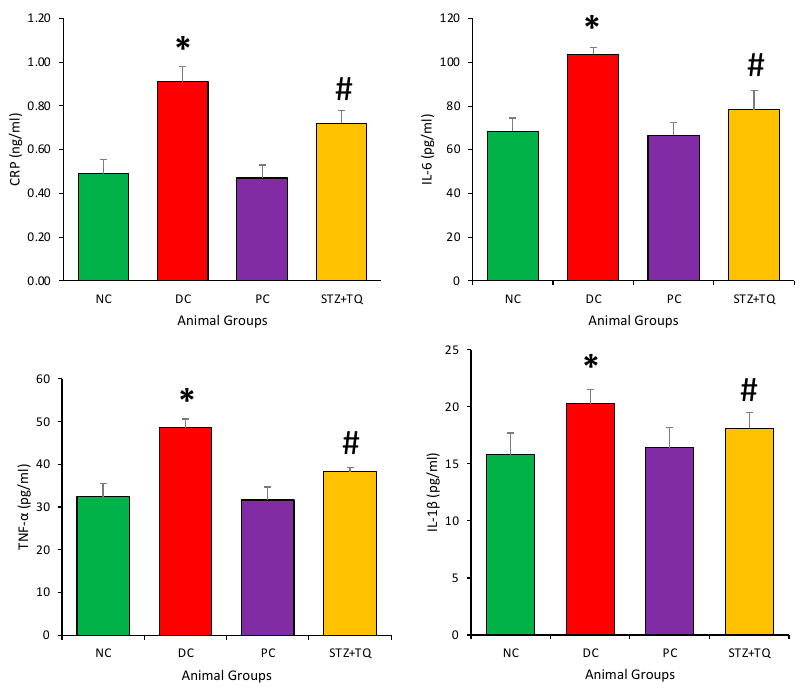
Figure 9. The inflammatory markers level in different groups of rats after 8 weeks of continues treatment. The experimental animals were uniformly divided into each group ( n = 8 per group). Data are means ± standard error of the mean (SEM). Groups: Normal control (NC); disease control (DC) i.e., STZ-treated group; positive control (PC) animal treated with STZ and Glibenclamide; diabetic rats treated with TQ (STZ + TQ). * p < 0.05 (significant difference of between DC vs. NC), # p < 0.05 (significant difference between DC vs. STZ + TQ).